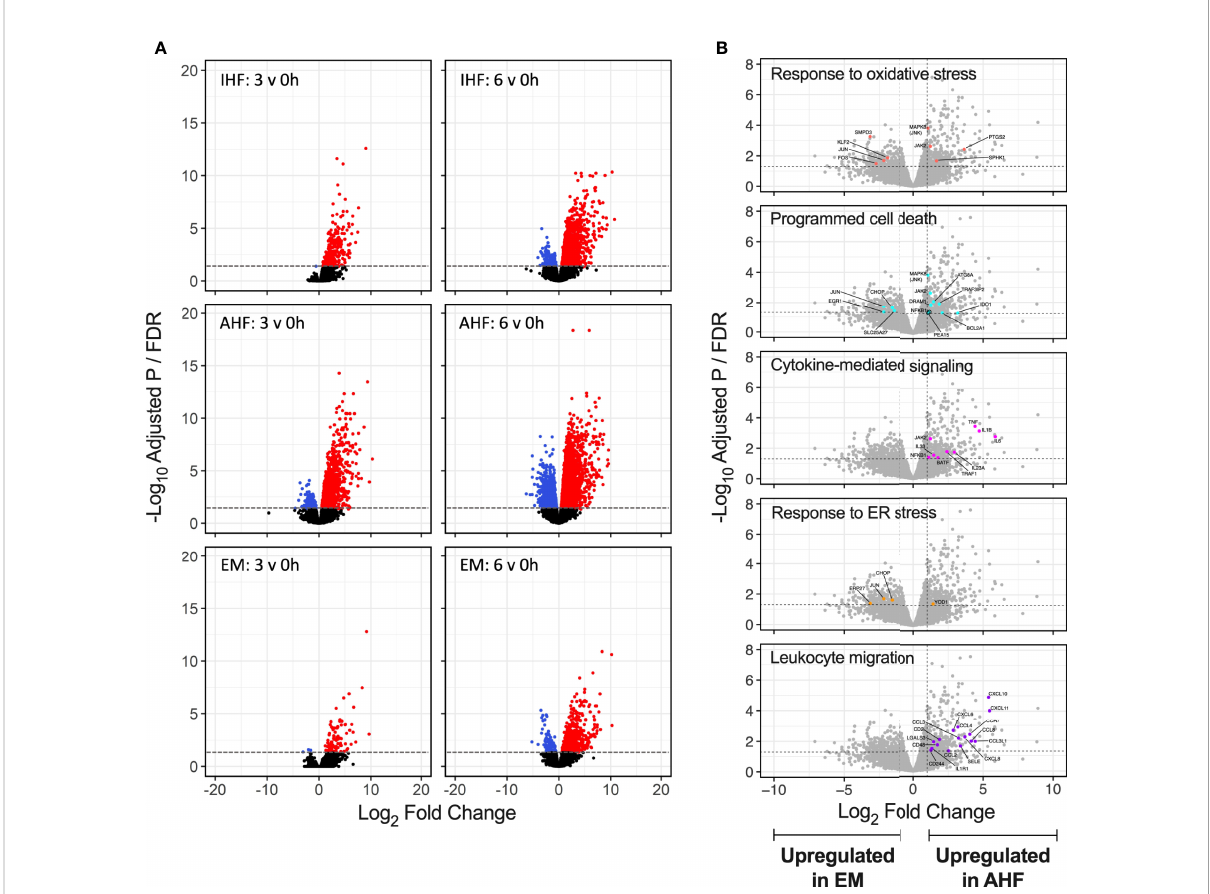
FIGURE 4 Volcano plots of differentially expressed genes during NMP. (A) Signi fi cant upregulated (red) and downregulated (blue) genes shown for each group at 3 and 6 hours of NMP compared to pre-perfusion. The absolute number of differentially expressed genes appeared lower in the EM compared to AHF and IHF groups. (B) Select GO term volcano plots shown for comparison of EM to AHF groups at 6 hours of NMP. Signi fi cant differentially expressed genes within each GO term are shown in color and labelled. Genes related to in fl ammatory signaling and leukocyte migration were signi fi cantly upregulated in AHF compared to EM livers. Horizontal dashed line indicates the adjusted P value (false discovery rate) cutoff of 0.05. Vertical dashed lines indicate the log 2 fold change cutoff -1 and 1. NMP, normothermic machine perfusion; GO, gene ontology; AHF, adequate hepatocellular function; IHF, inadequate hepatocellular function; EM, emricasan; ER, endoplasmic